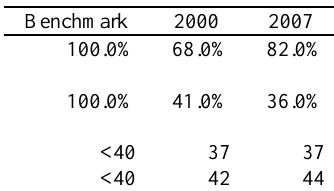
Table 4: Quality of education indicators and